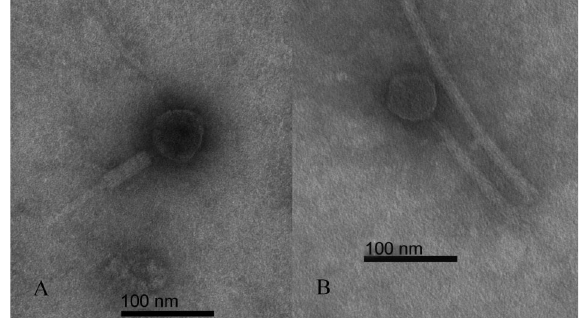
Figure 2. Family Myoviridae bacteriophages isolated from clinical samples. The scale bar corresponds to 100 nm. A , Phage isolated from Pseudomonas aeruginosa P9705. B , Phage isolated from P. aeruginosa